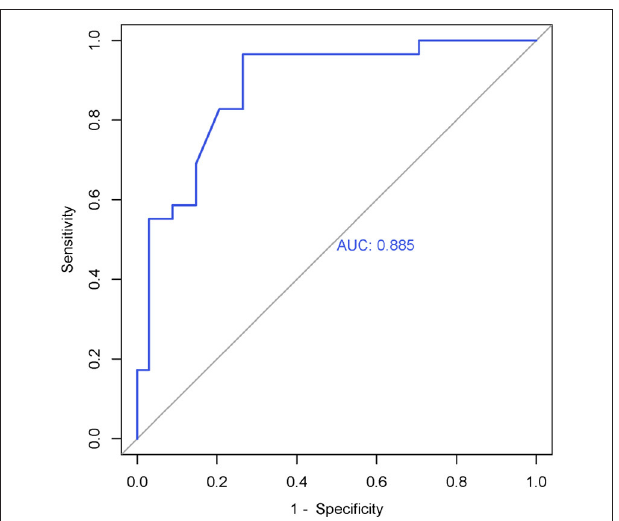
FIGURE 3 | ROC curve of the right SMA’s cortical thickness (0 weeks) in the responder group. AUC = 0.885 (95% CI = 0.803–0.968), sensitivity = 73.5%, specificity = 96.6%, cutoff value =